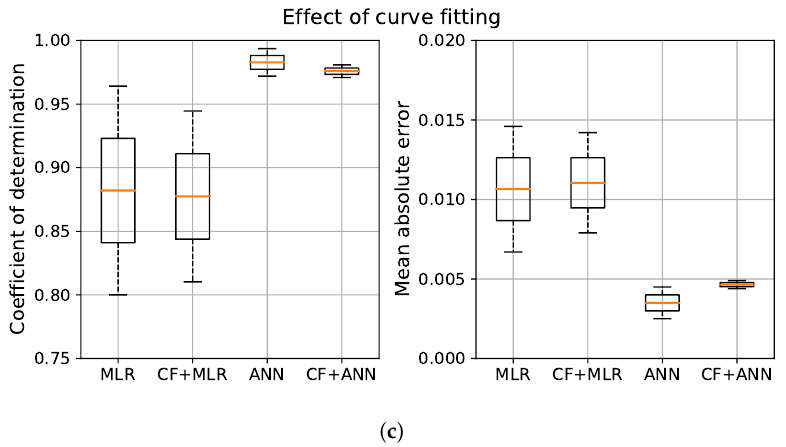
Figure 8. Box plots of prediction performance for model cases: ( a ) modeling method, ( b ) variable selection method, ( c ) effect of curve fitting.